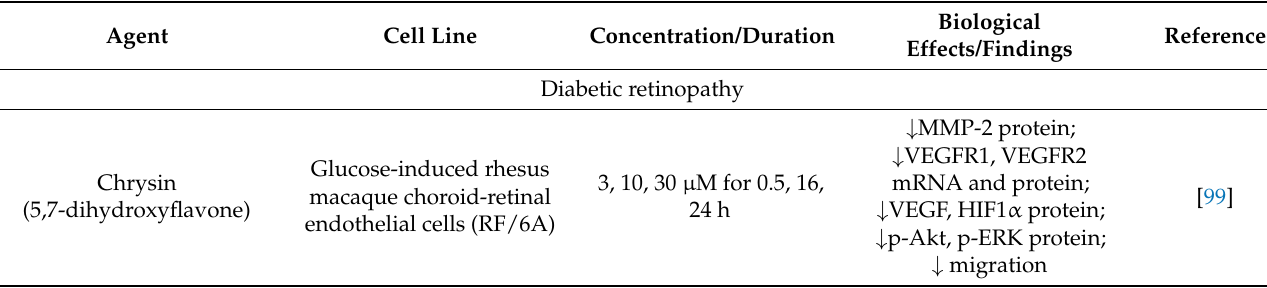
Table 1. Overview of in vitro studies associated with the modulation of MMPs and TIMPs in eye